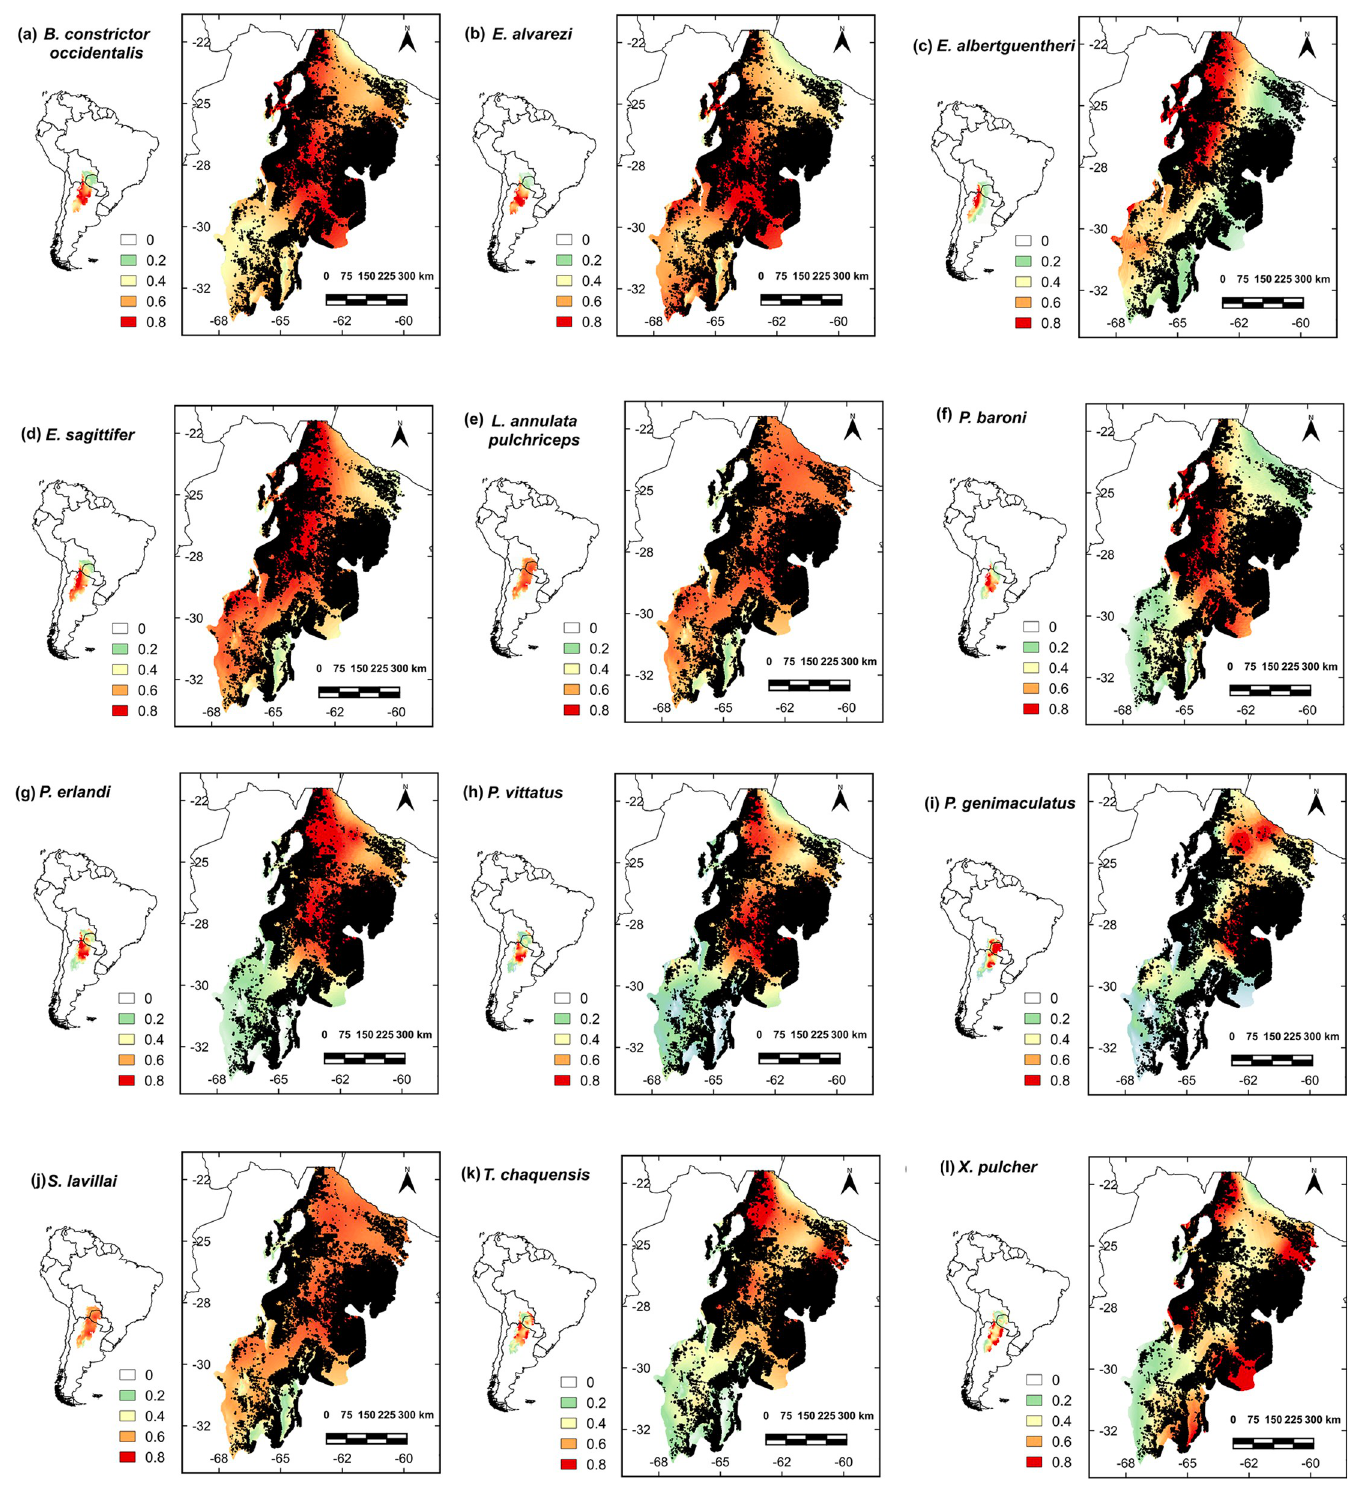
Fig 1. ENMs for snake species in the Argentinian Dry Chaco considering deforestation since 1976 to 2017. Warmer colors (red, orange and yellow) indicate higher habitat suitability while colors from green to white indicate the lowest predicted values. Black color indicates deforested areas. (a) B . constrictor occidentalis ; (b) E . alvarezi ; (c) E . albertguentheri ; (d) E . sagittifer modestus ; (e) L . annulata pulchriceps ; (f) P . baroni ; (g) P . erlandi ; (h) P . vittatus ; (i) P . genimaculatus ; (j) S . lavillai ; (k) T . chaquensis ; (l) X . pulcher .